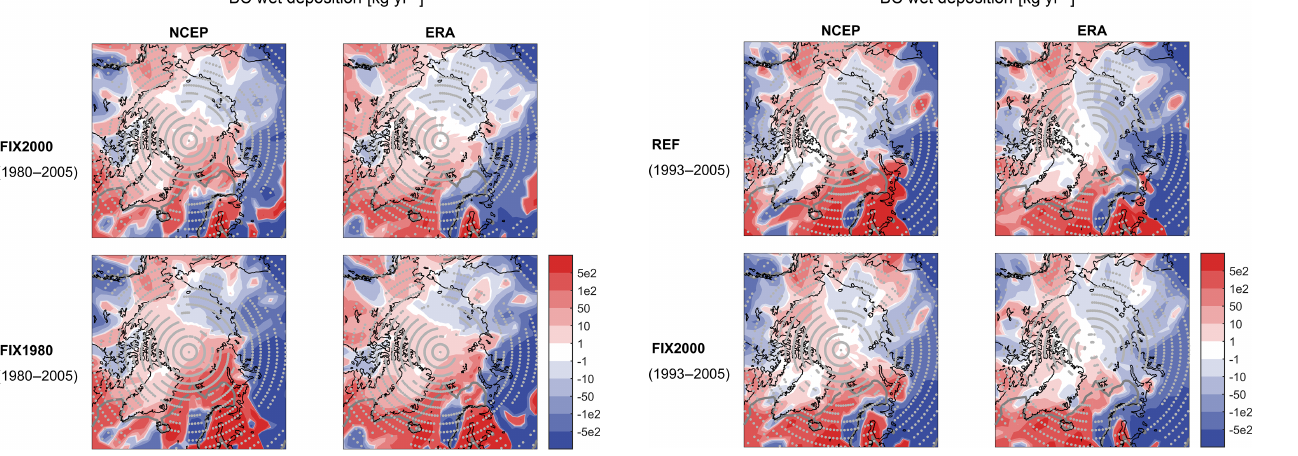
Figure 10. Four different estimates (see also Table 1) of to- tal trends of maximum likelihood BC wet deposition (kgyr − 1 ) associated with three atmospheric circulation patterns (To- tal = NAO + SB + ENSO). The grey line represents the mean win- ter sea ice and snow cover larger than 50% from 1980 to now. Grey dots represent the grid points with trend significant at 5% level.